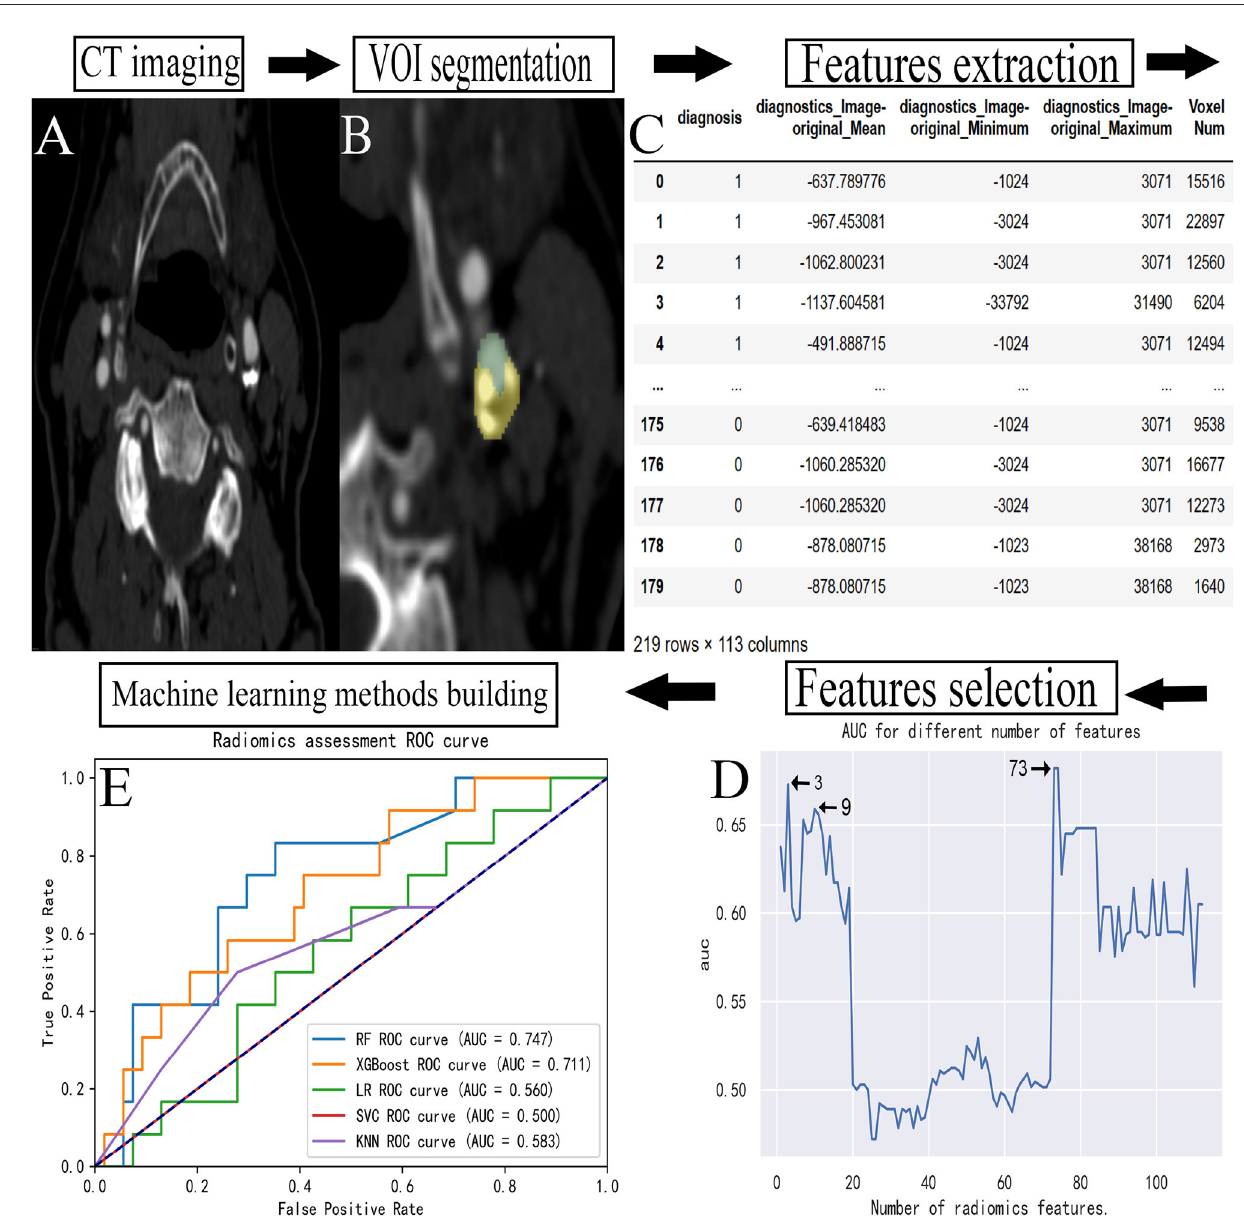
FIGURE1 Flowchart for building a predictive model. (A) The carotid CTA image of a patient. (B) The manual VOI segmentation was performed on an image. (C) The radiomic features extracted from each VOI. (D) The feature data were selected. (E) The establishment of prediction models. CTA, computed tomography angiography; VOI, volume of interest; ROC, receiver operating characteristic; AUC, area under